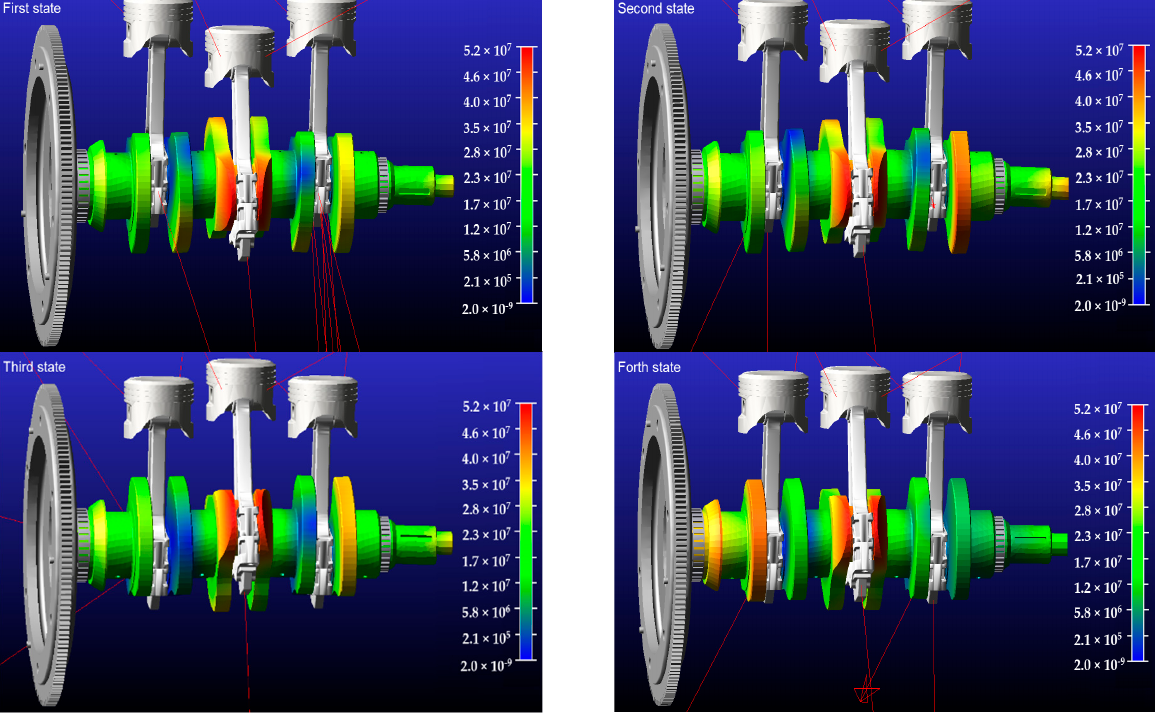
Figure 22. Maximum stress state.